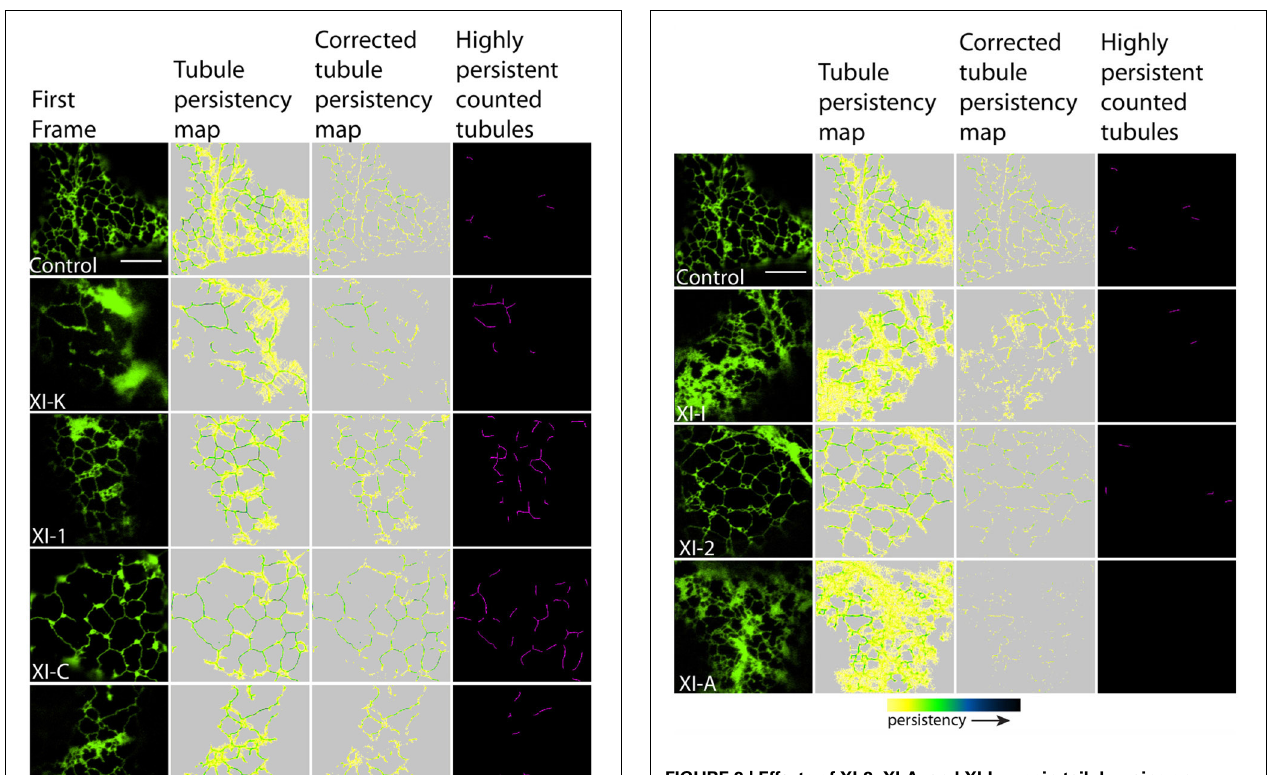
FIGURE 3 | Effects of XI-2, XI-A, and XI-I myosin tail domains on persistent ER tubules identified with co-expressed GFP-HDEL. Left-hand panel is the first frame of a 50 frame movie. Middle two panels are tubule persistency expressed as the sum of skeletonized tubules that persist for at least five frames (7.9s). The corrected tubule persistency subtracts out contributing skeletons from cisternal regions. The yellow-green-blue-black persistency scale represents persistency from 7.9 to 80s. Highly persistent tubules are those that are counted for Figure 4 , being both greater than 0.2 µ m 2 and persisting for at least a third of total movie time (black to green on the persistency scale with black representing persistency through the whole 80s and green representing persistency for approximately 23s). Note, control refers to cells only expressing the ER marker GFPHDEL (green, left hand